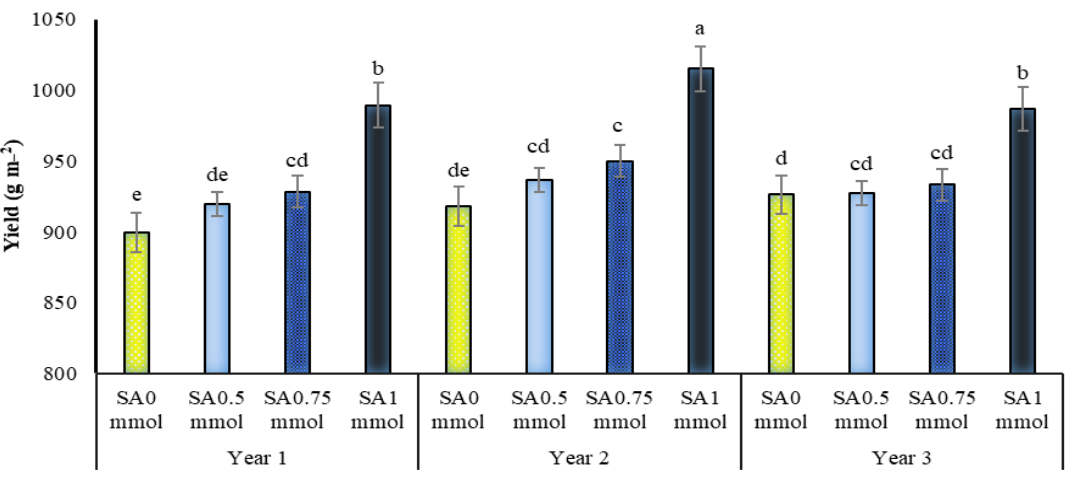
Figure 8. Dual interaction of experimental years (2016–2017, 2017–2018, and 2018–2019) and salicylic